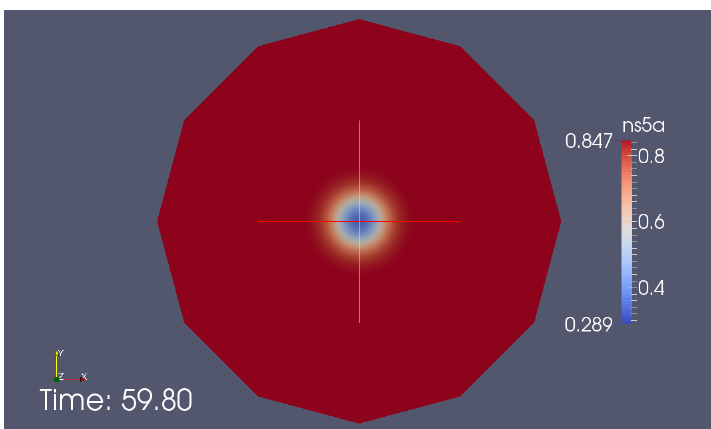
Figure 8. Classical 2D simulation of the FRAP process: Screenshot of supplemental movie “S3 Video in supplementary material”. Simulation of FRAP experiment on simple 2D planar continuum geometry. (Red high concentration, blue low concentration). At the beginning, the bleached region has low concentration, but the 2D diffusion refills it again during the process, i.e. the color shifts slowly to red again because from the high concentration unbleached region around, fluorescating NS5A is diffusing inside. The ER structure is neglected.